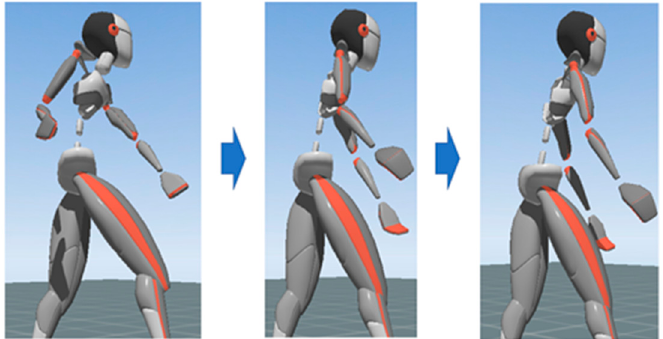
Figure 7. The upper-body mowing